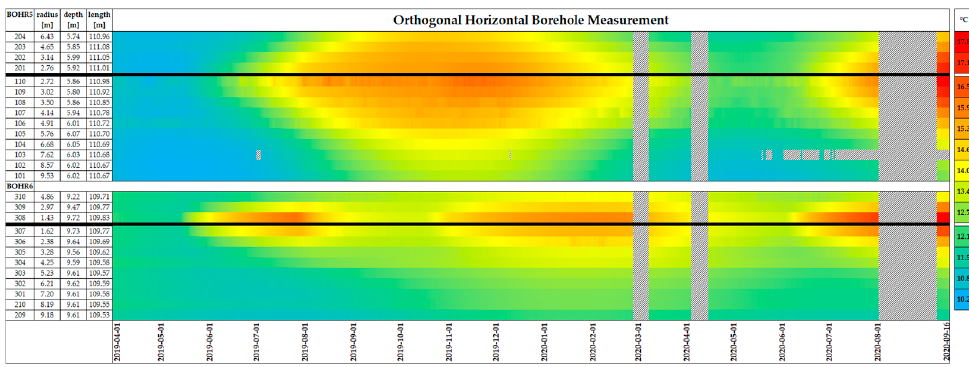
Figure 20. Orthogonal borehole temperature measurement ~109 m.